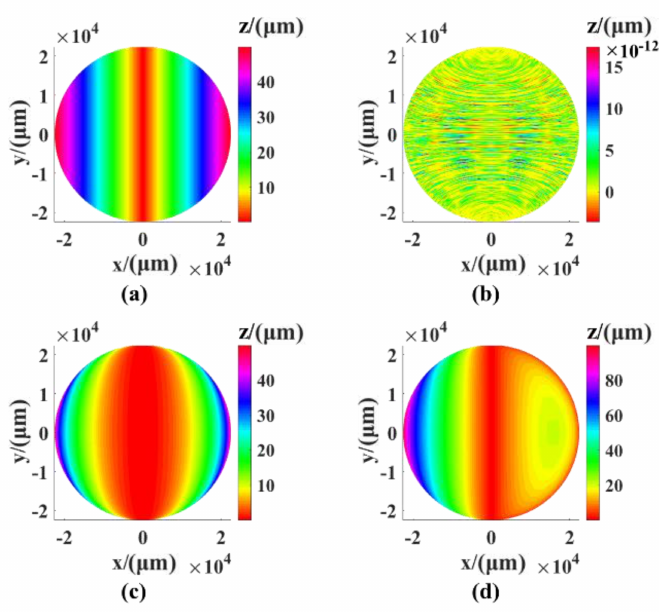
Figure 5. The shape error caused by the position deviation in different directions: ( a ) The X direction, ( b ) the Y direction, ( c ) the Z direction, and ( d ) the XYZ